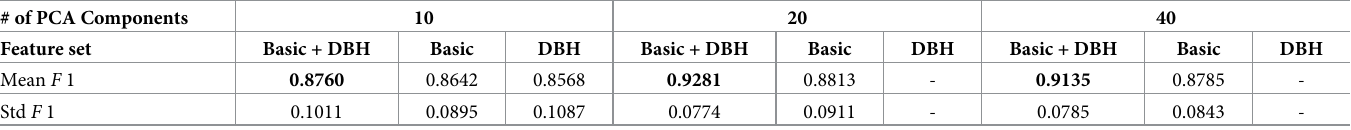
Table 7. The results of further experiments with the linear SVM on the three groups of feature types (Base + DBH, Base, and DBH).